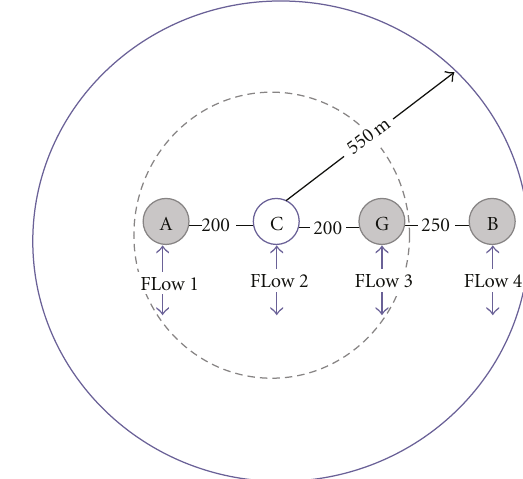
Figure 6: A simple topology. Nodes A, B, and G are interfering neighbors of node C. Nodes A and G are the direct neighbors of node C; node B is the carrier sensing neighbor of node